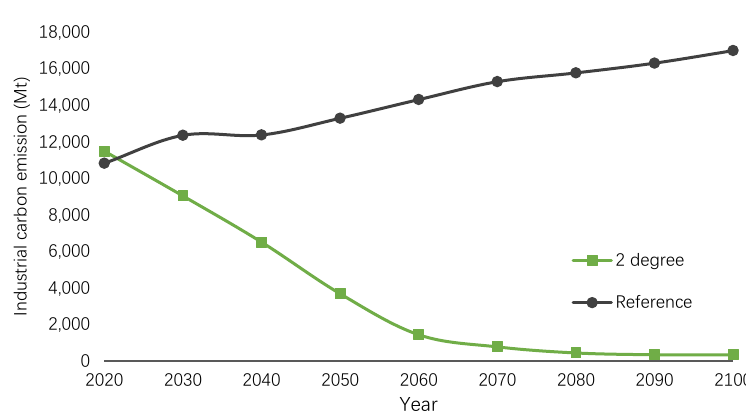
Figure 7. Projected industrial carbon emissions in 2-degree and reference scenarios.